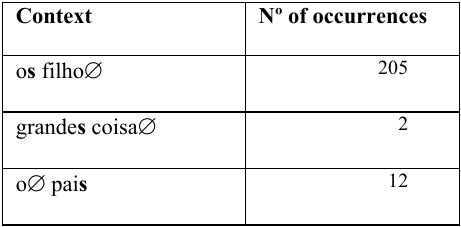
Table 2: Patterns of defective number